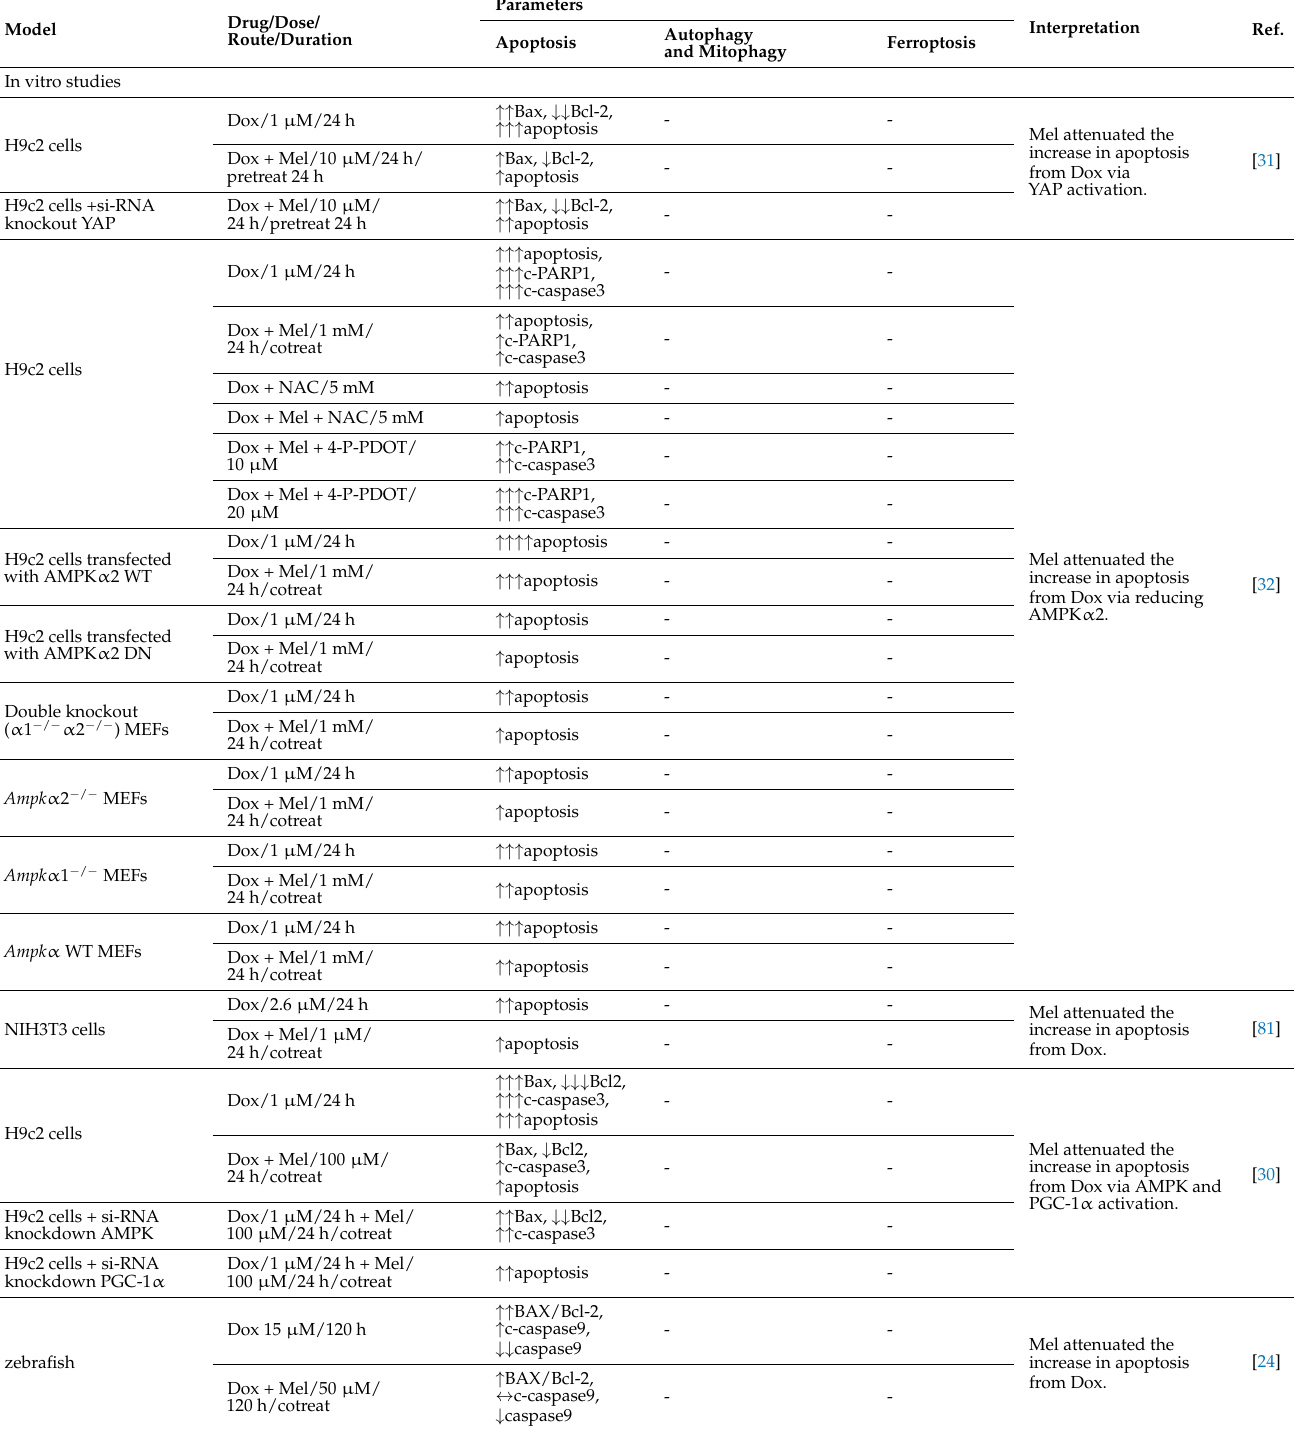
Table 3. Effects of melatonin on cellular death pathways in doxorubicin-induced cardiotoxicity: evidence from in vitro and in vivo